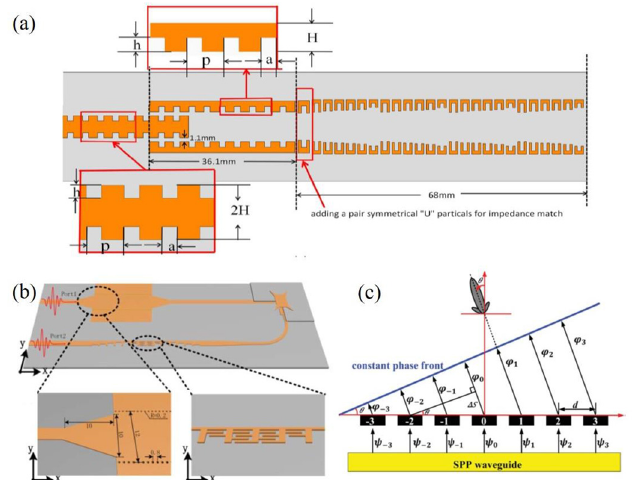
Fig. 8. (a) A two-element array fed by a compact SSPP feeding network [16]. (b) A broadband decoupling network for dual-band patch antennas [34]. (c) Sketch of the feeding with designable phase shift in